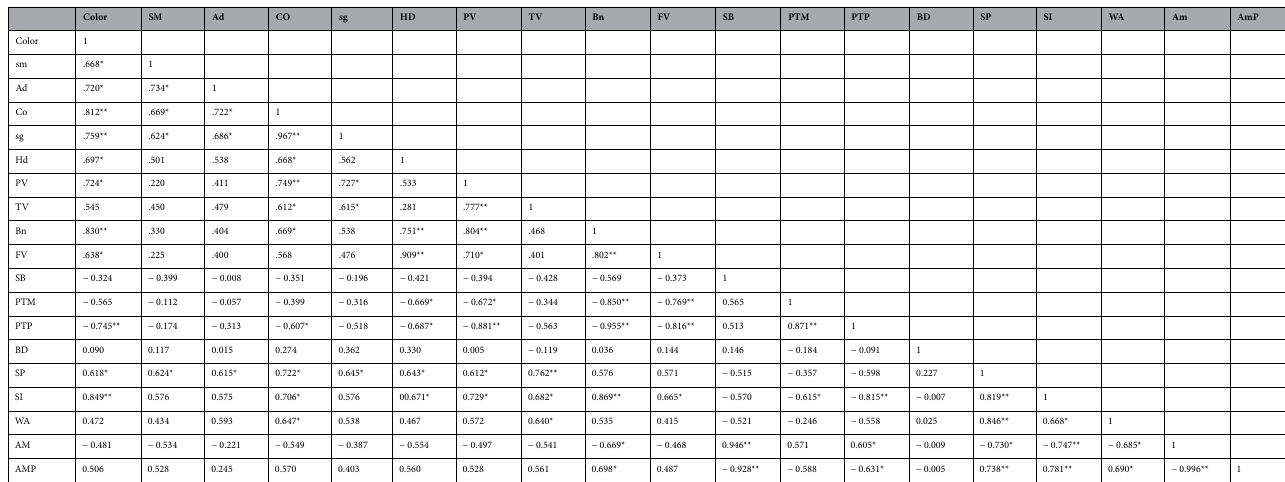
Table 5. Correlation coefficients between physicochemical, pasting and sensory properties. Sm smoothness, Ad adhesiveness, Co cohesiveness, sg springiness, Hd hardness, PV peak viscosity, TV trough viscosity, Bn amylopectin. **Correlation is significant at the 0.01 level; *Correlation is significant at the 0.05